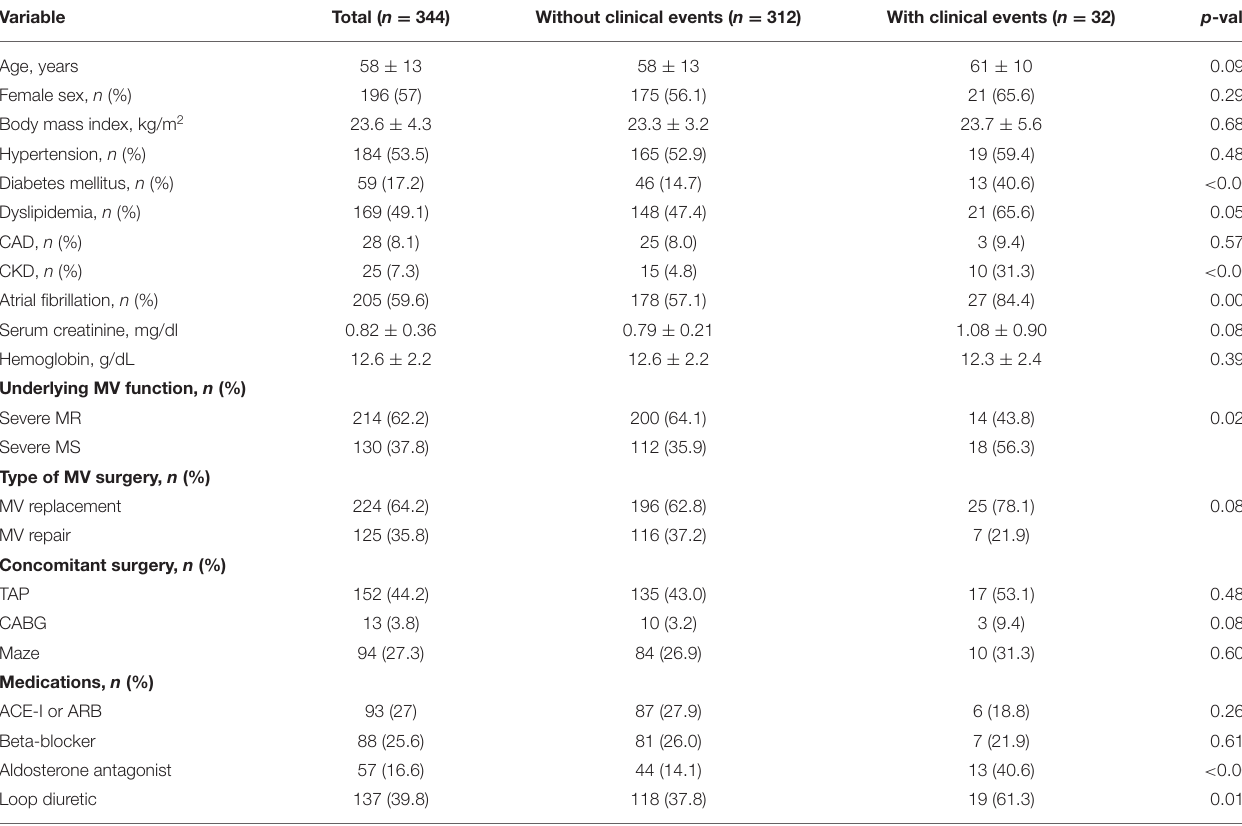
TABLE 1 | Baseline characteristics of the study population.